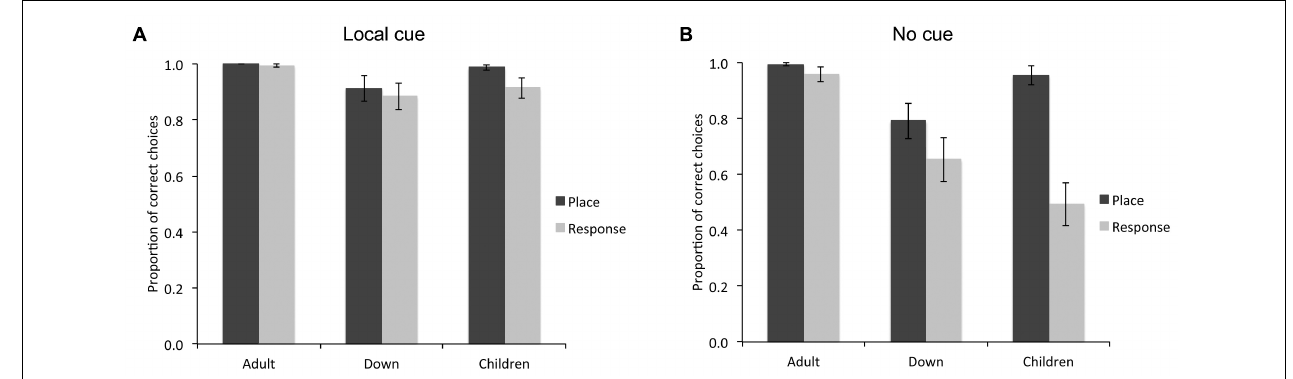
FIGURE 2 | Proportion of correct choices (i.e., choice of the rewarded location as the first choice upon entering the arena; mean ± SEM) made by individuals with DS ( n = 27), TD children ( n = 19), and TD adults ( n = 21) in the place learning and response learning tasks, in presence (A) or absence (B) of a local cue marking the reward